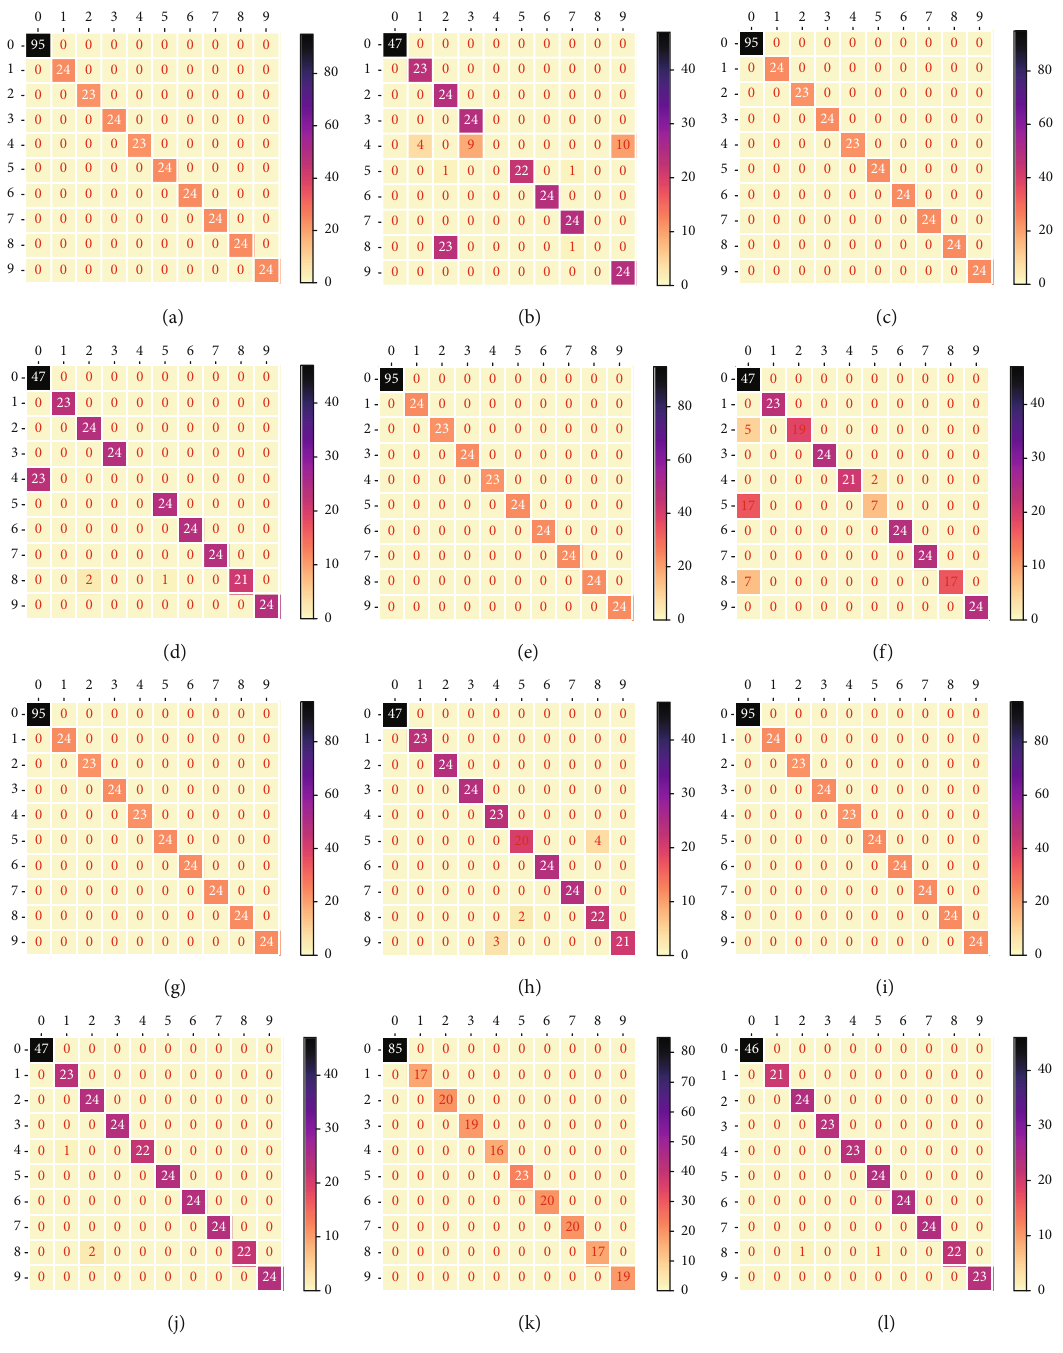
Figure 9: The confusion matrixes of test date in task 3 ⟶ 0 : (a) CNN source; (b) CNN target; (c) DAN source; (d) DAN target; (e) JAN source; (f) JAN target; (g) CORAL source; (h) CORAL target; (i) DANN source; (j) DANN target; (k) WDATL source; (l) WDATL